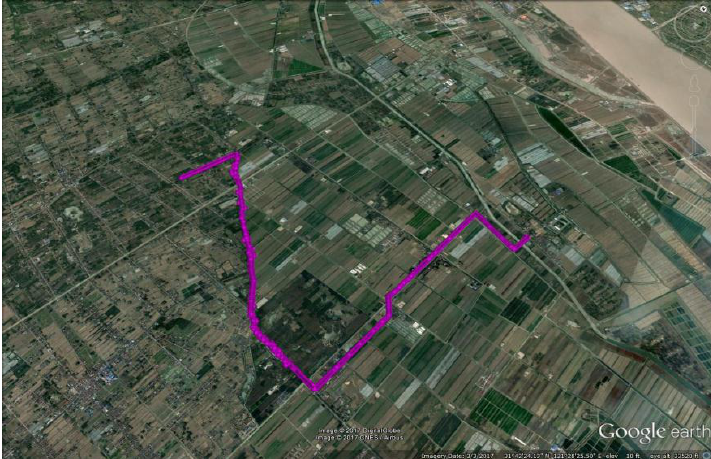
Figure 10. Vehicle route for data logging (courtesy of Google Earth).